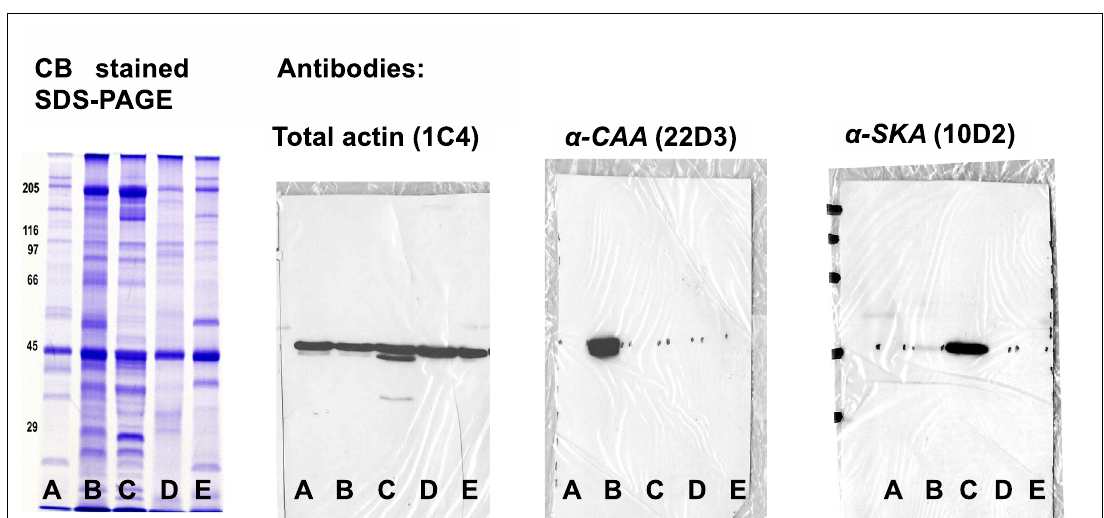
Supplemental Figure 1. Immunodetection of α -CAA and α -SKA in total tissue extracts by Western blots. Coomassie Blue (CB) staining of bovine aorta (A), rat heart (B), rat skeletal muscle (C), human platelets (D), and chicken gizzard (E) total extracts. Immunodetection of total actin, α -CAA and α -SKA with specific mAbs in total extracts of the same tissues.